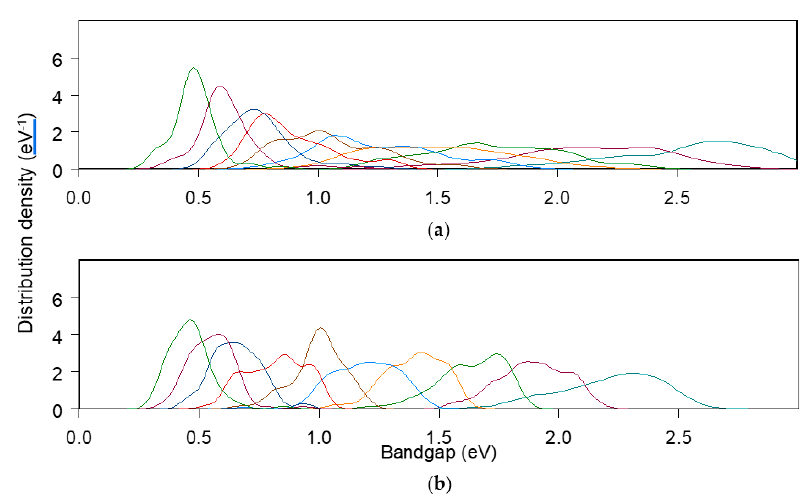
Figure 13. Distribution of the bandgap energy of the optimized (to the spectrum and other climate conditions given by random numbers according to Figure 2) multi-junction solar cells under the modeled fluctuation in the climate in Miyazaki, Japan (N 31.83 ◦ , E 131.42 ◦ ). This is an example of 10 junctions. Please note that the histogram of the calculated optimized bandgap energy in each junction is normalized so that the integral of the range becomes unity. Also, note that the overlap of each peak does not mean that the higher bandgap junction has lower bandgap energy than that of the lower peak. It is constrained that the bandgap structure was equivalently modeled by allowing the bandgap energy of the ( i + 1)th junction to be equal or greater than that of the ( i )th junction, but not allowing the bandgap energy of the ( i + 1)th junction to be less than that of the ( i )th junction. The y -axis is normalized so that the integration of the distribution becomes unity: ( a ) Normal multi-junction solar cell; ( b ) Super-multi-junction solar cell. Table 4. List of the set of the bandgap of the super-multi-junction solar cell. Bandgap Energy (eV) from Top to Bottom